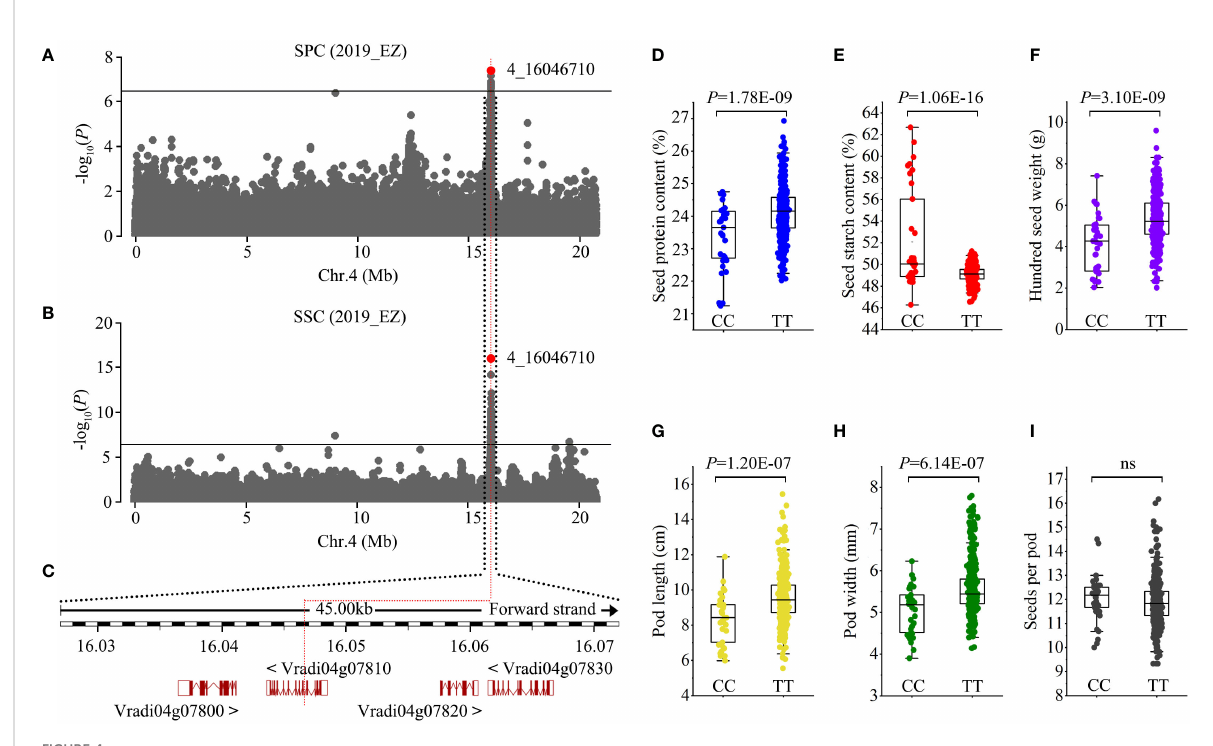
FIGURE 4 Identi fi cation of Chr4_16046710 seed protein content loci. (A, B) Manhattan plots of GWAS on seed protein content (SPC) and seed starch content (SSC) in the population. Horizontal solid lines indicate the signi fi cance threshold ( P < 3.87E-07, – log 10 P = 6.41). The red dot indicates the peak SNP (4_16046710, C/T). (C) Genes in the region associated with the peak SNP. The peak SNP is located at the ninth intron of Vradi04g07810 . (D-I) Box plots of seed protein content (D) , seed starch content (E) , 100-seed weight (F) , pod length (G) , pod width (H) , and seeds per pod (I) for the two haplotypes. Statistical signi fi cance for each trait was determined by a two-tailed t -test. ns, no signi fi